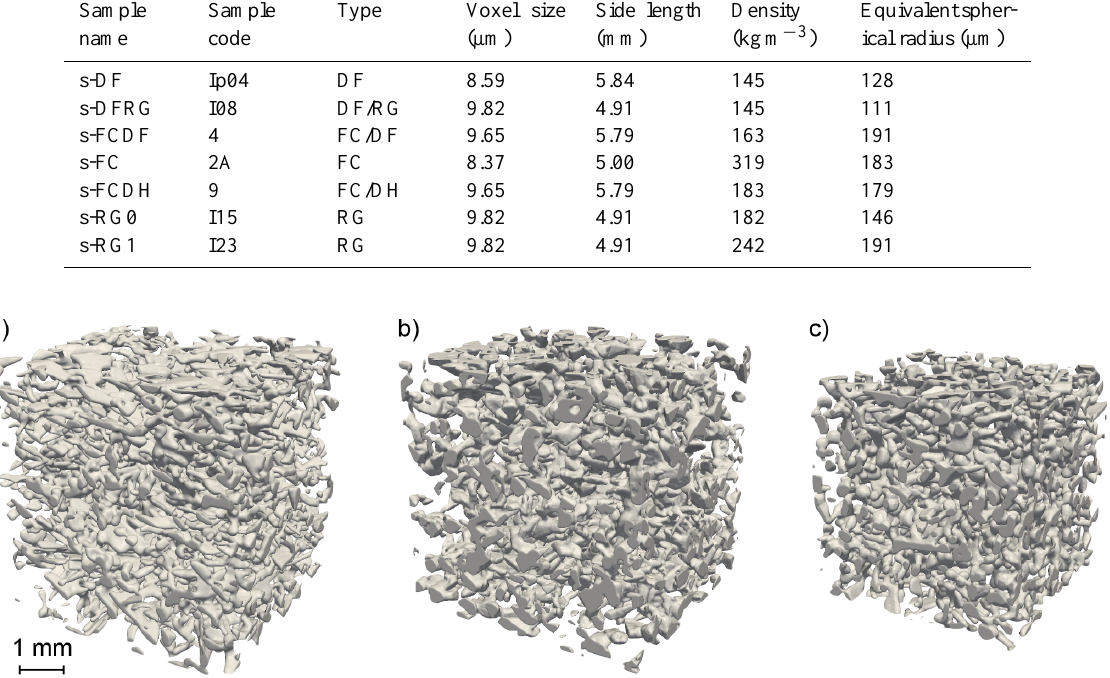
Figure 1. Example of different snow microstructural patterns used in this study: (a) sample s-DF, (b) sample s-FCDH and (c) sample s-RG0. The scale is the same for the three